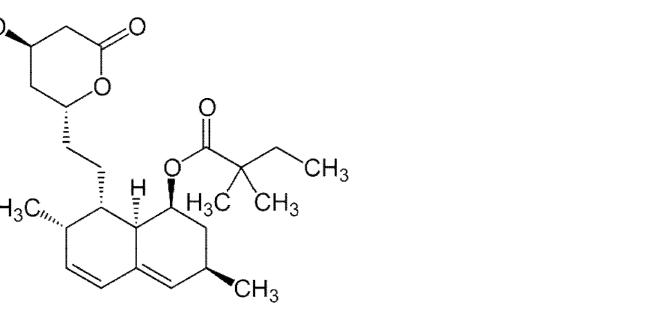
Table 1. Composition of the feed solutions and suspensions further used for the preparation of non-filled and composite PVA cryogels.